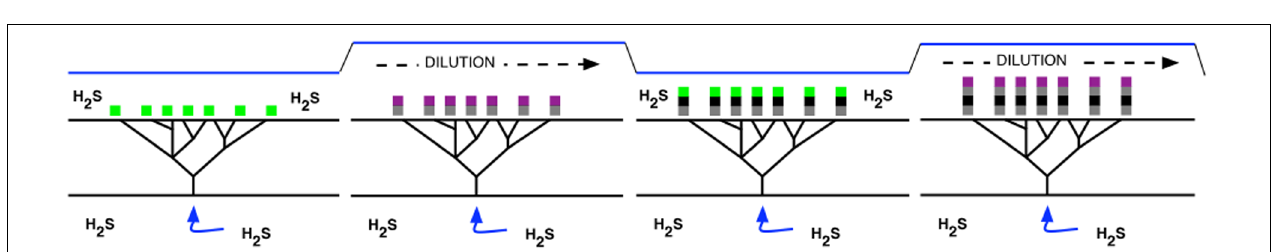
FIGURE 5 | A model for seeding of stromatolites. Left (green box): H 2 S is exhaled from a hydrothermal vent or fissure, accumulates, and serves as an electron donor to Type I photosynthesis in photoautotrophic growth. Right (purple box): H 2 S is depleted by dilution through tidal action or rainfall, leaving Type II, photoheterotrophic growth, using organic compounds (gray) that accumulated as products of photosynthesis during the previous, photoautotrophic stage.